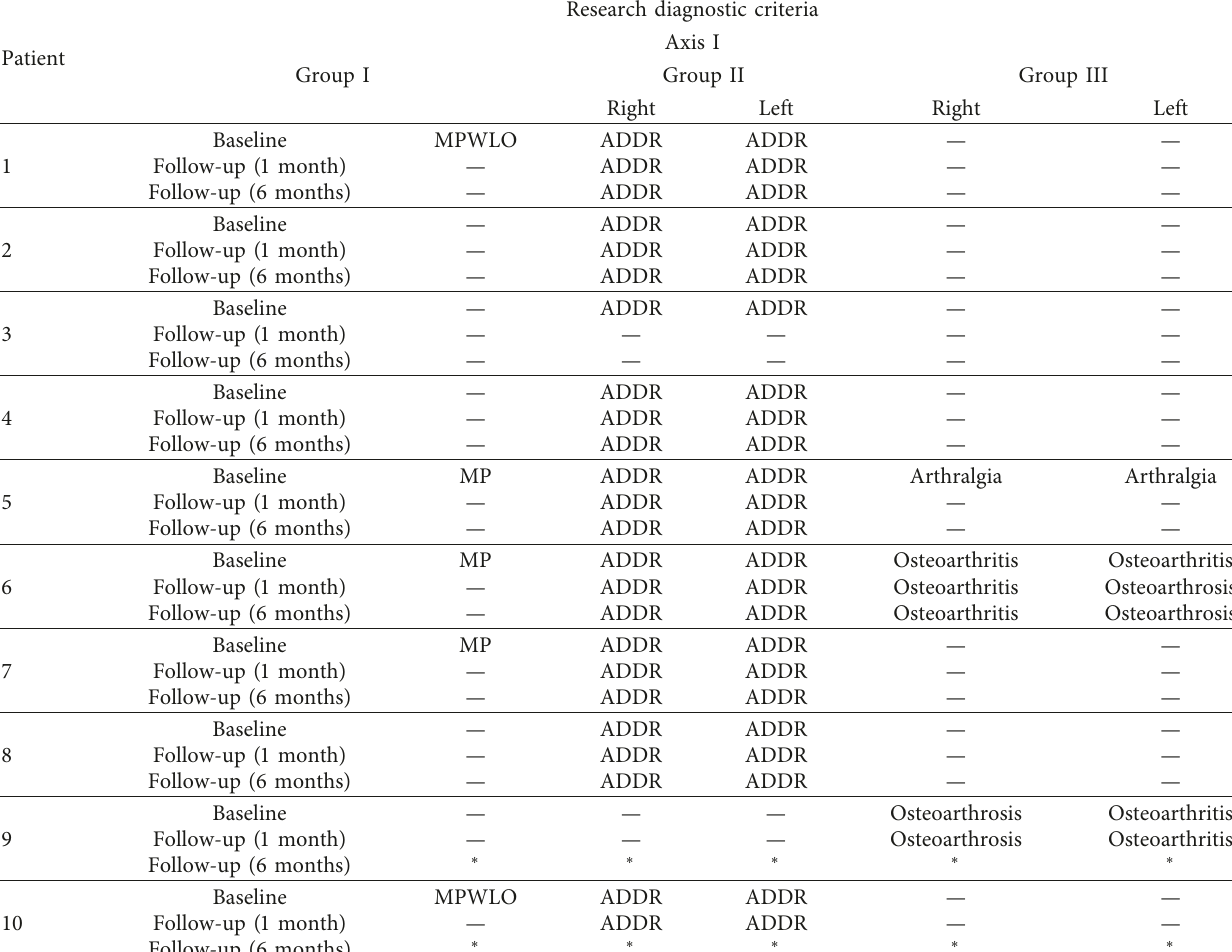
Table 2: RDC/TMD diagnosis at baseline and follow-ups (1 and 6 months).